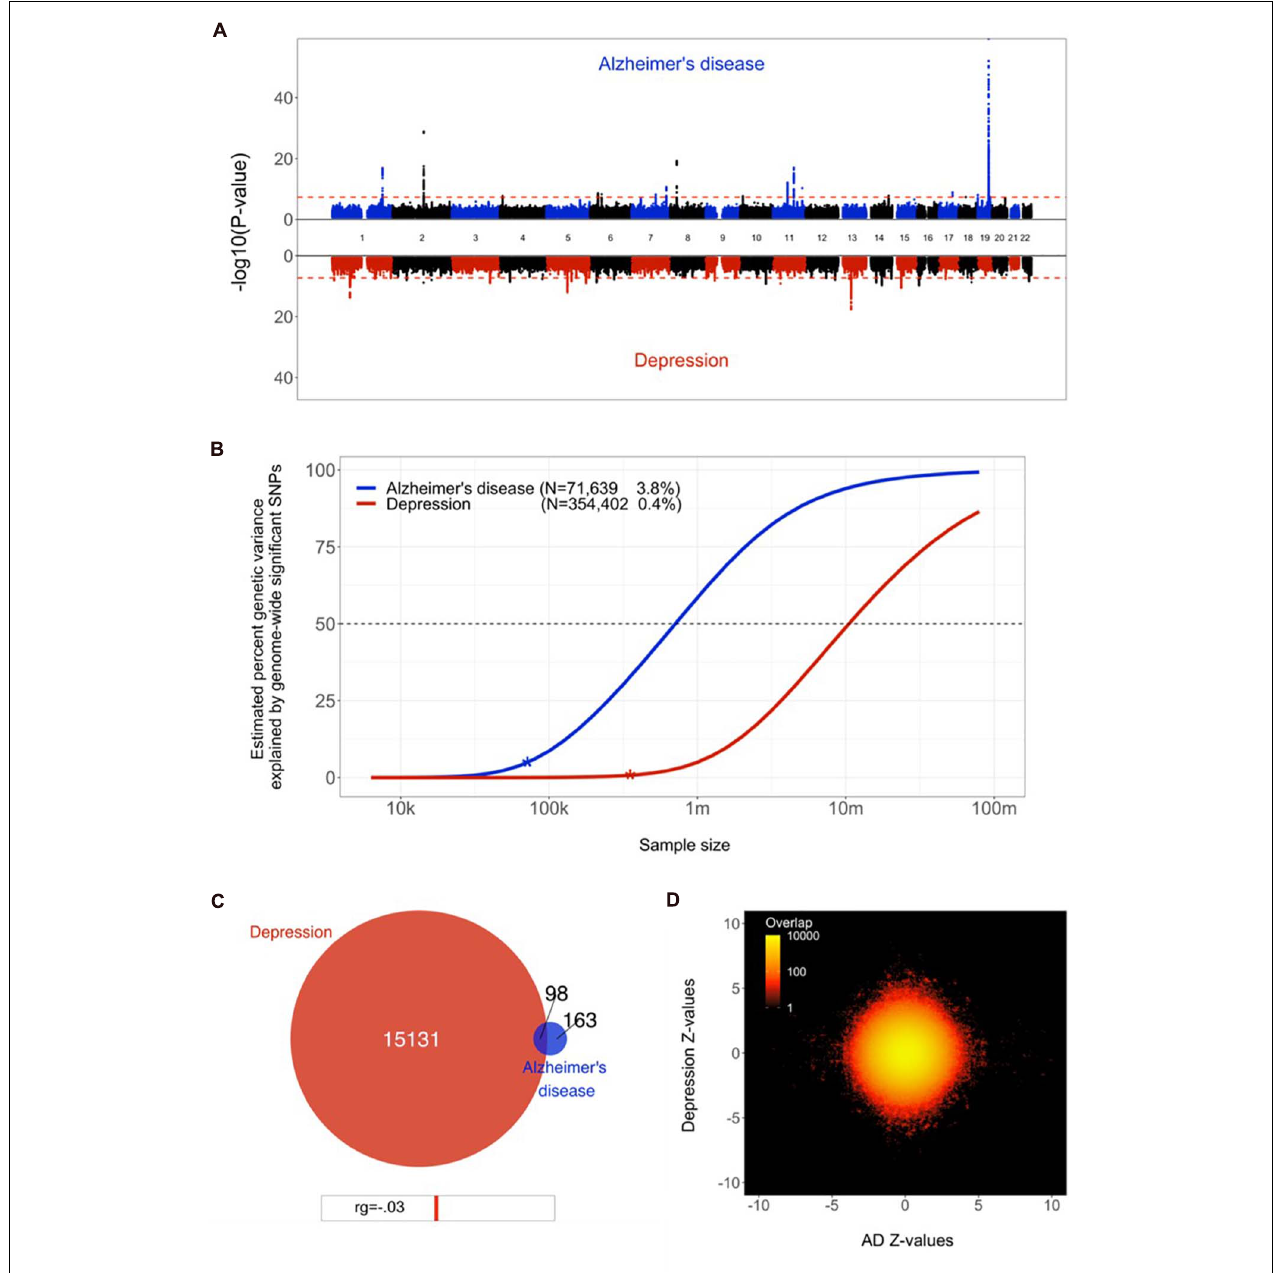
FIGURE 1 | Genetic overlap between Alzheimer’s disease (AD) and depression. (A) Miami plot, contrasting the observed − log 10 ( p -values), shown on the y -axis, of each SNP for AD (top half, blue) with depression (bottom half, red). The x -axis shows the relative genomic location, grouped by chromosome, and the red dashed lines indicate the whole-genome significance threshold of 5 × 10 − 8 . (B) Estimated percent of genetic variance explained by SNPs surpassing the genome-wide significance threshold, on the y axis, as a function of sample size, depicted on the x axis on a log 10 scale, for AD and depression. Current sample sizes and percentages of genetic variance explained by discovered SNPs are shown in parentheses. (C) Venn diagram depicting the estimated number of causal variants shared between AD and depression and unique to either of them. Below the diagram, we show the estimated genetic correlation. (D) Bivariate density plot, illustrating the relationship between the observed GWAS Z -values for AD (on the x -axis) and depression (on the y